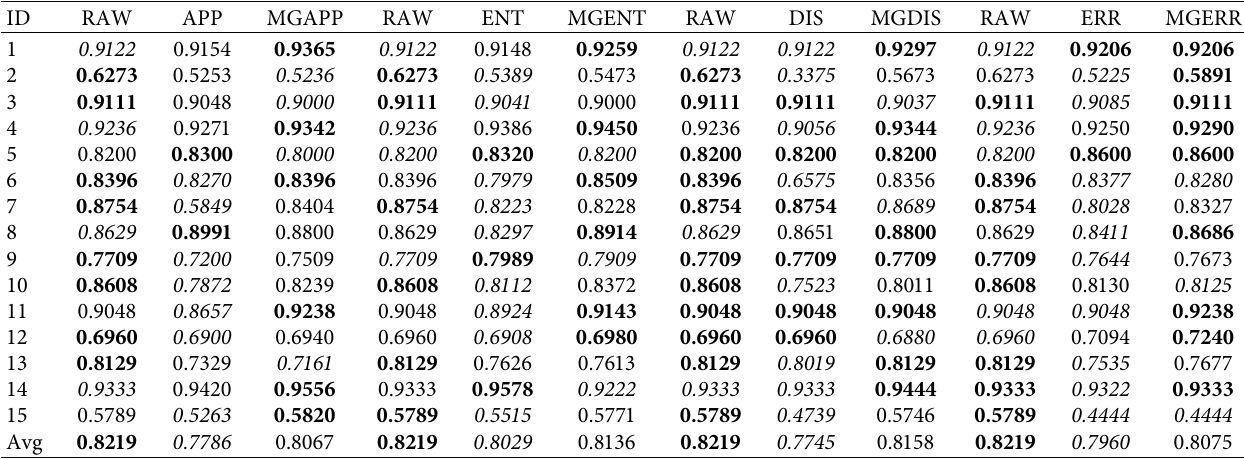
Table 8: Comparison among the classification accuracies with using CRAT.